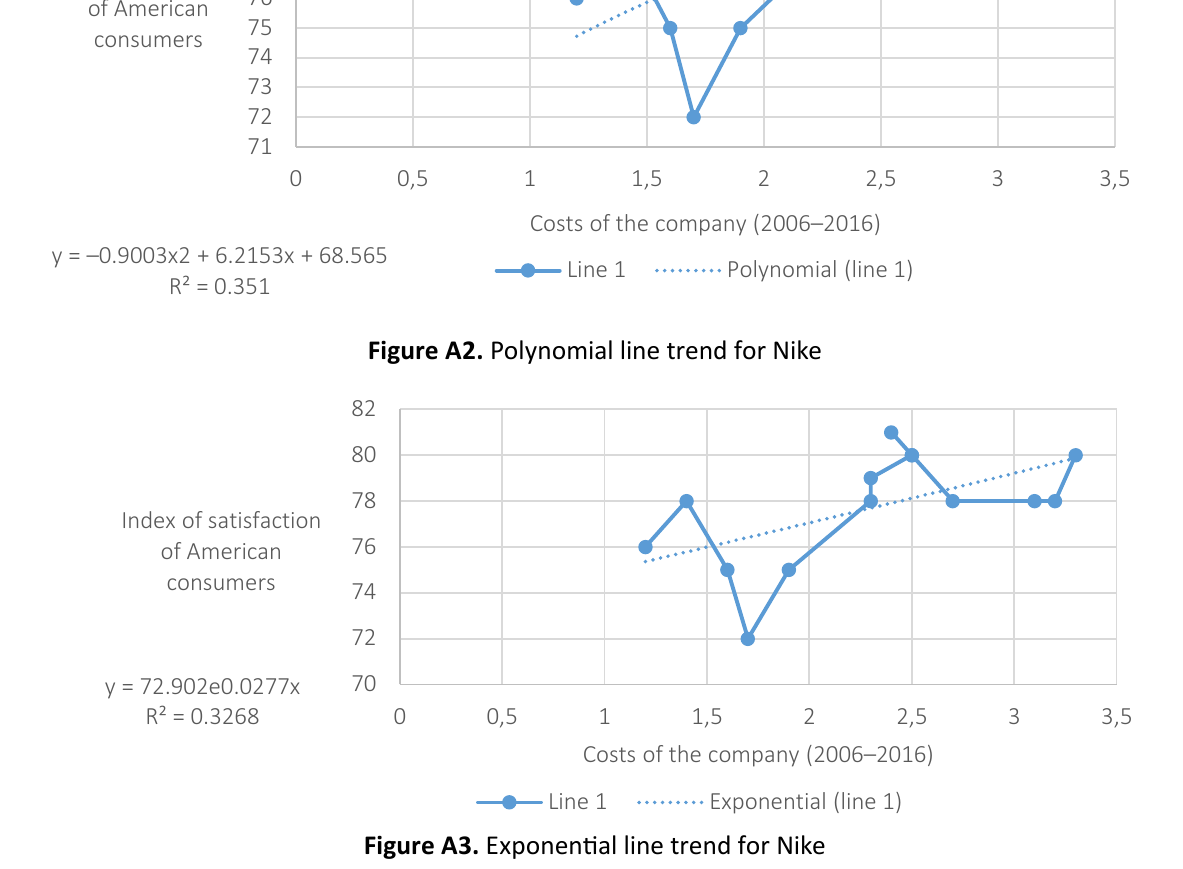
Figure A3. Exponential line trend for